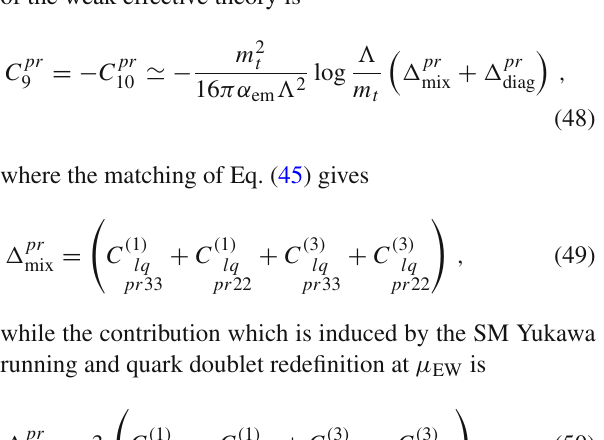
Fig. 3 Predictions for R K ( ∗ ) in the central bin (blue lines) coming from the running of WCs C lu (left panel) and C ( 1 ) muons, taking (cid:3) = 1 TeV. The green band corresponds to region allowed by the constraints listed in Sect. 3.2. See text for details